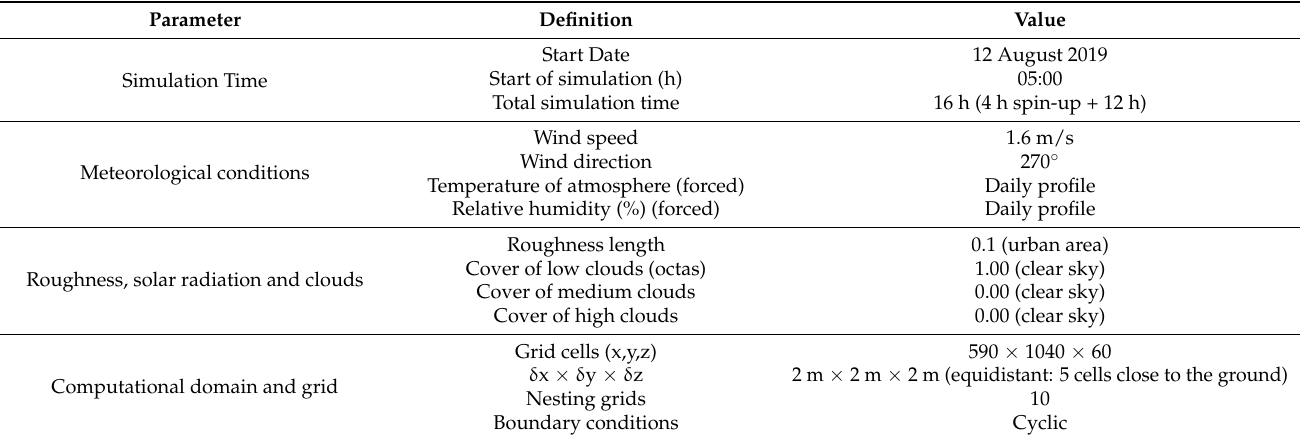
Table 1. Initial and boundary conditions used in ENVI-met simulations.